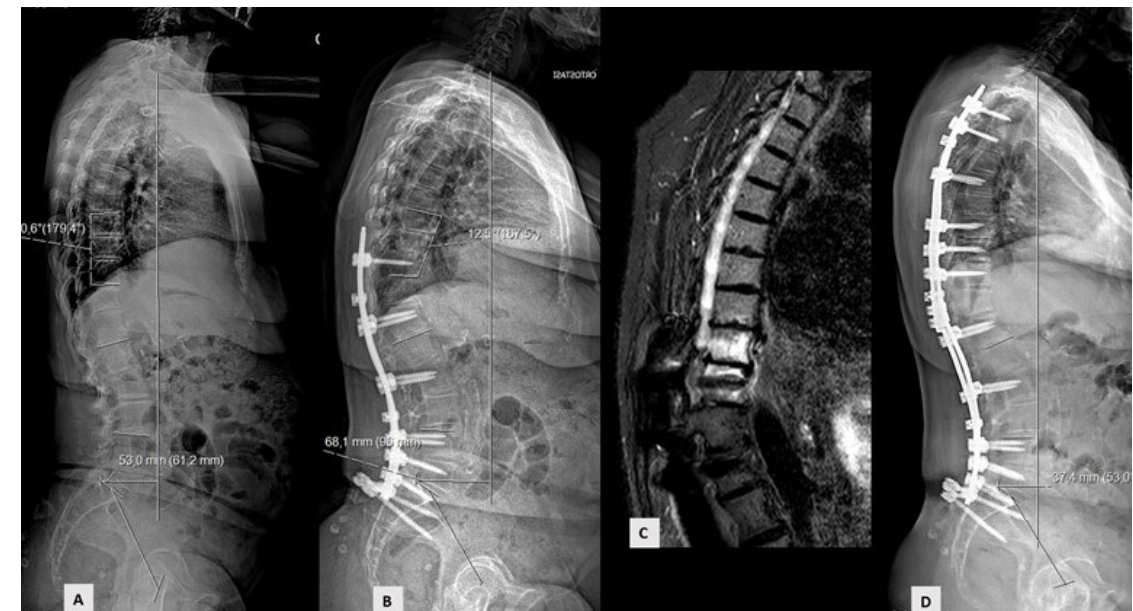
Figure 1. Example of proximal junctional kyphosis; ( A ) early postoperative proximal junctional angle; ( B ) 4-month increase (>10°) in kyphosis between the upper instrumented vertebra—UIV— and two vertebrae above UIV.